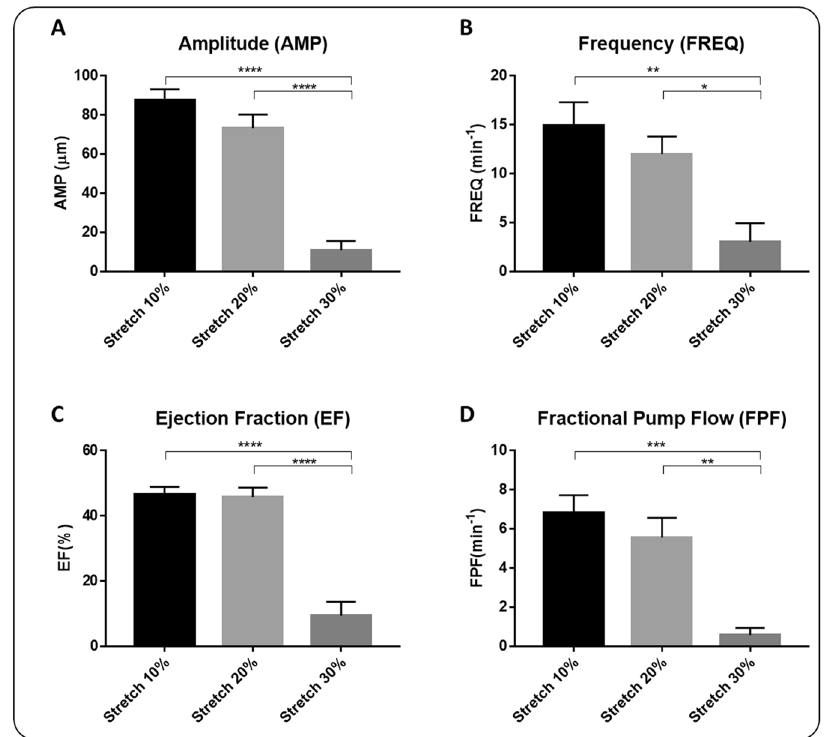
Figure 3. Effect of axial stretch on contractile function of lymphatic vessels. The contractile parameters were plotted as a function of the axial stretch (n = 6), including amplitude of contractions (AMP; Panel A), frequency of contractions (FREQ; Panel B), ejection fraction (EF; Panel C), and fractional pump flow (FPF; Panel D). The pressure was set to 2 mmHg for all experiments. All data are presented as mean ( ± SE) and statistical significance was tested via ANOVA and Bonferroni post-hoc tests ( * p < 0.05, ** p <